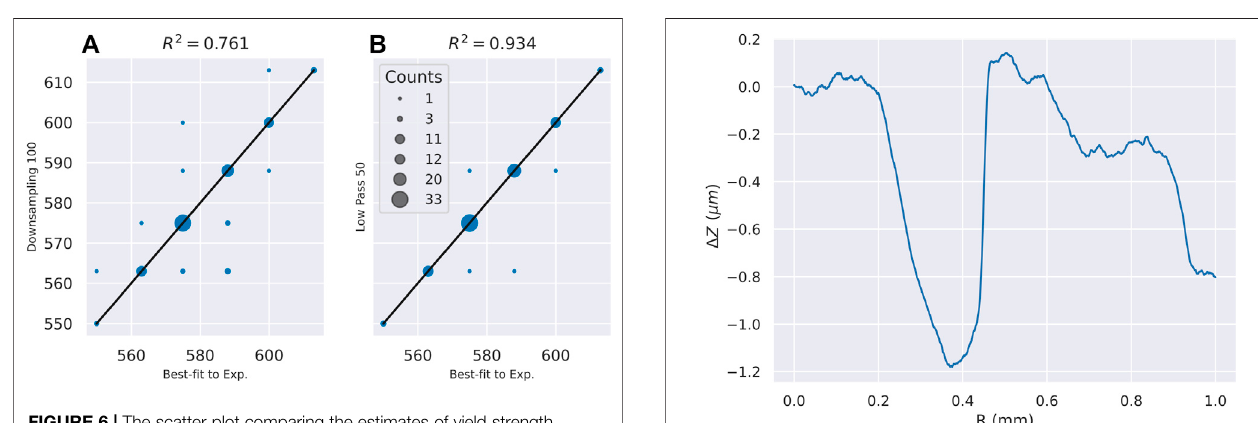
FIGURE 6 | The scatter plot comparing the estimates of yield strength obtained by fi tting modelled pro fi les to the raw experiment data against the yield strength estimates from fi tting modelled pro fi les to the noise fi ltered experiment data using (A) the downsampling from PIP, and (B) using a low-pass fi lter.